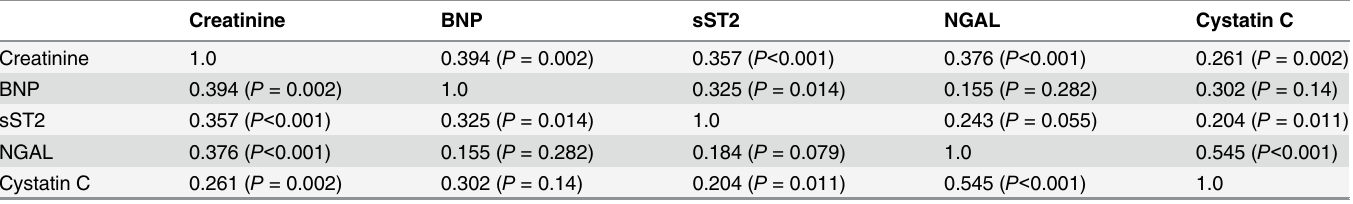
Table 3. Spearman ’ s correlation analysis of creatinine and the biomarkers of heart failure and renal injury. Creatinine BNP